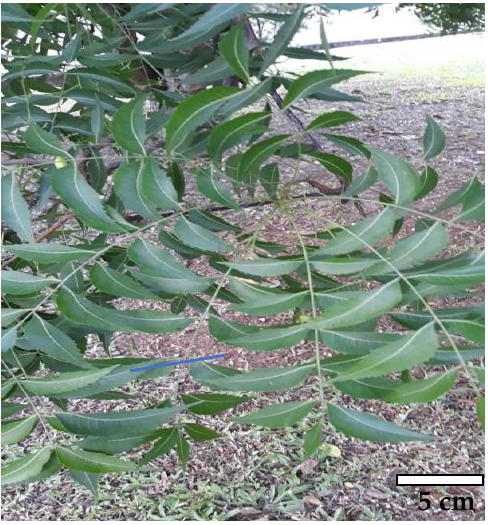
Figure 2. Azadirachta indica plant leaves.